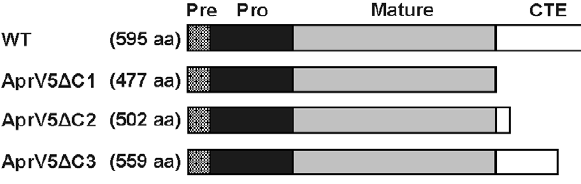
Figure 2. Schematic representation of the C-terminal deleted AprV5 derivatives. The number of amino acid residues in each derivative is indicated as are the pre-, pro-, mature and C-terminal extension (CTE) regions.